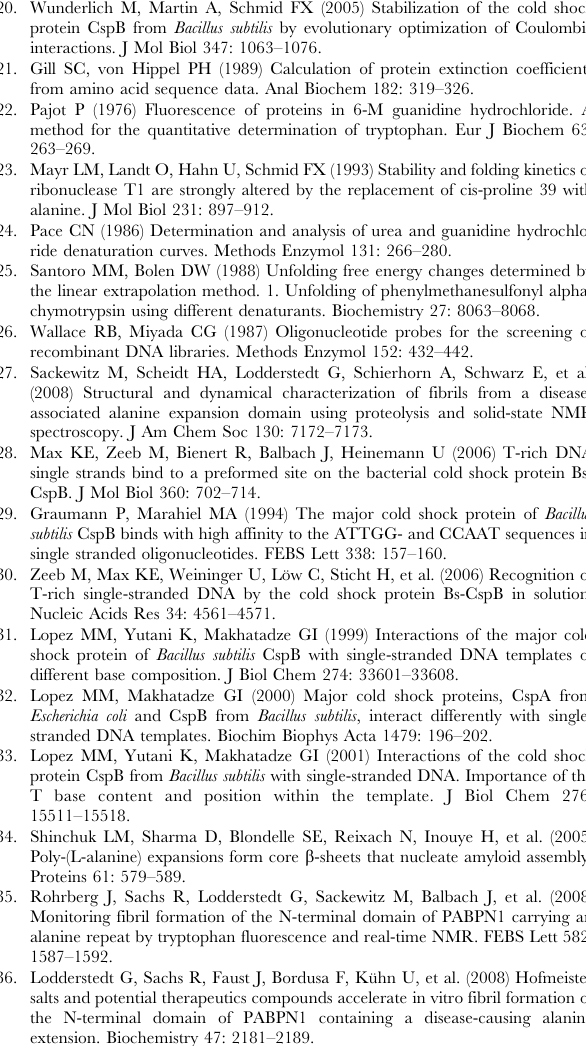
Figure S5 Characterization of the variants with MCspB by far-UV-CD (A) and dT7 binding (B). In A , variants with 10 alanines are black, variants with 17 alanines are gray; variants